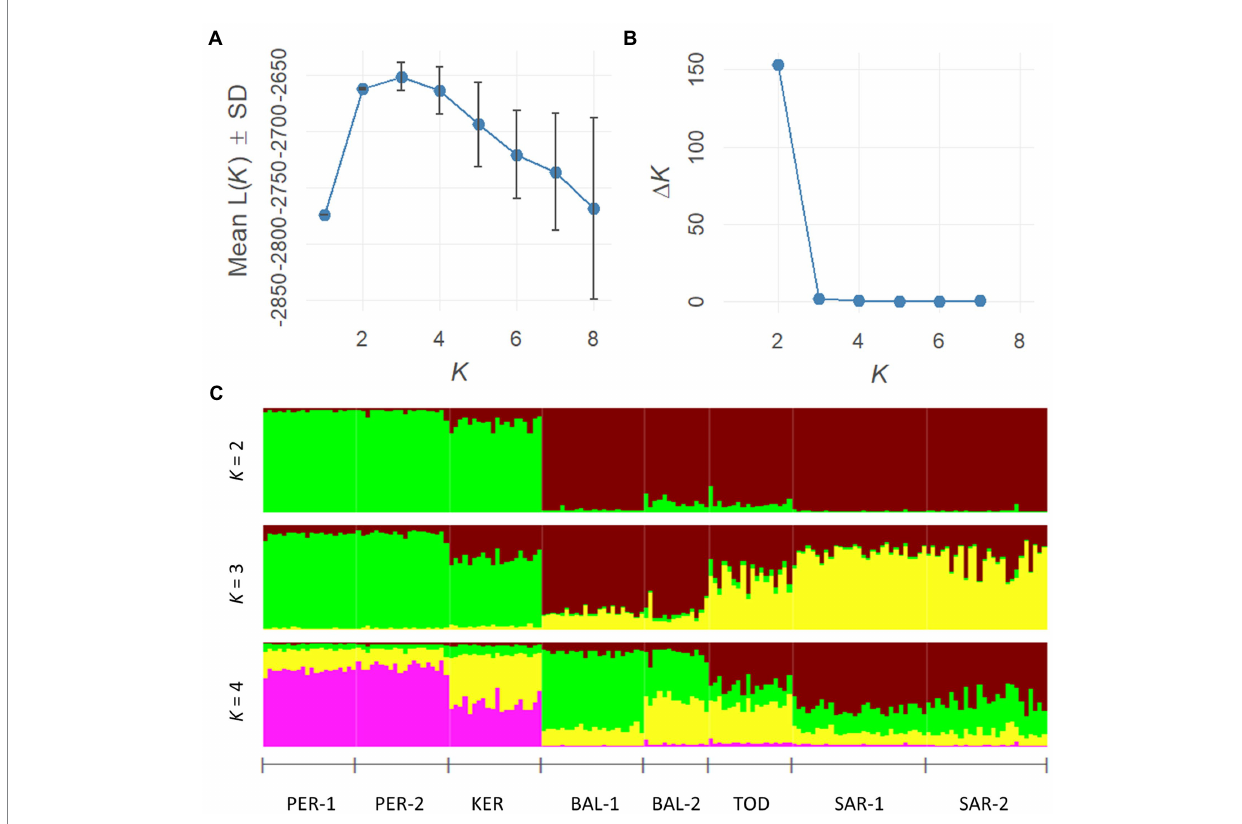
FIGURE 3 Estimation of the best subpopulation numbers based on Mean L( K ) (±SD) and Δ K values (A,B) . Genetic structural plot of eight Scots pine populations (acronyms are as in Table 1) (C) .